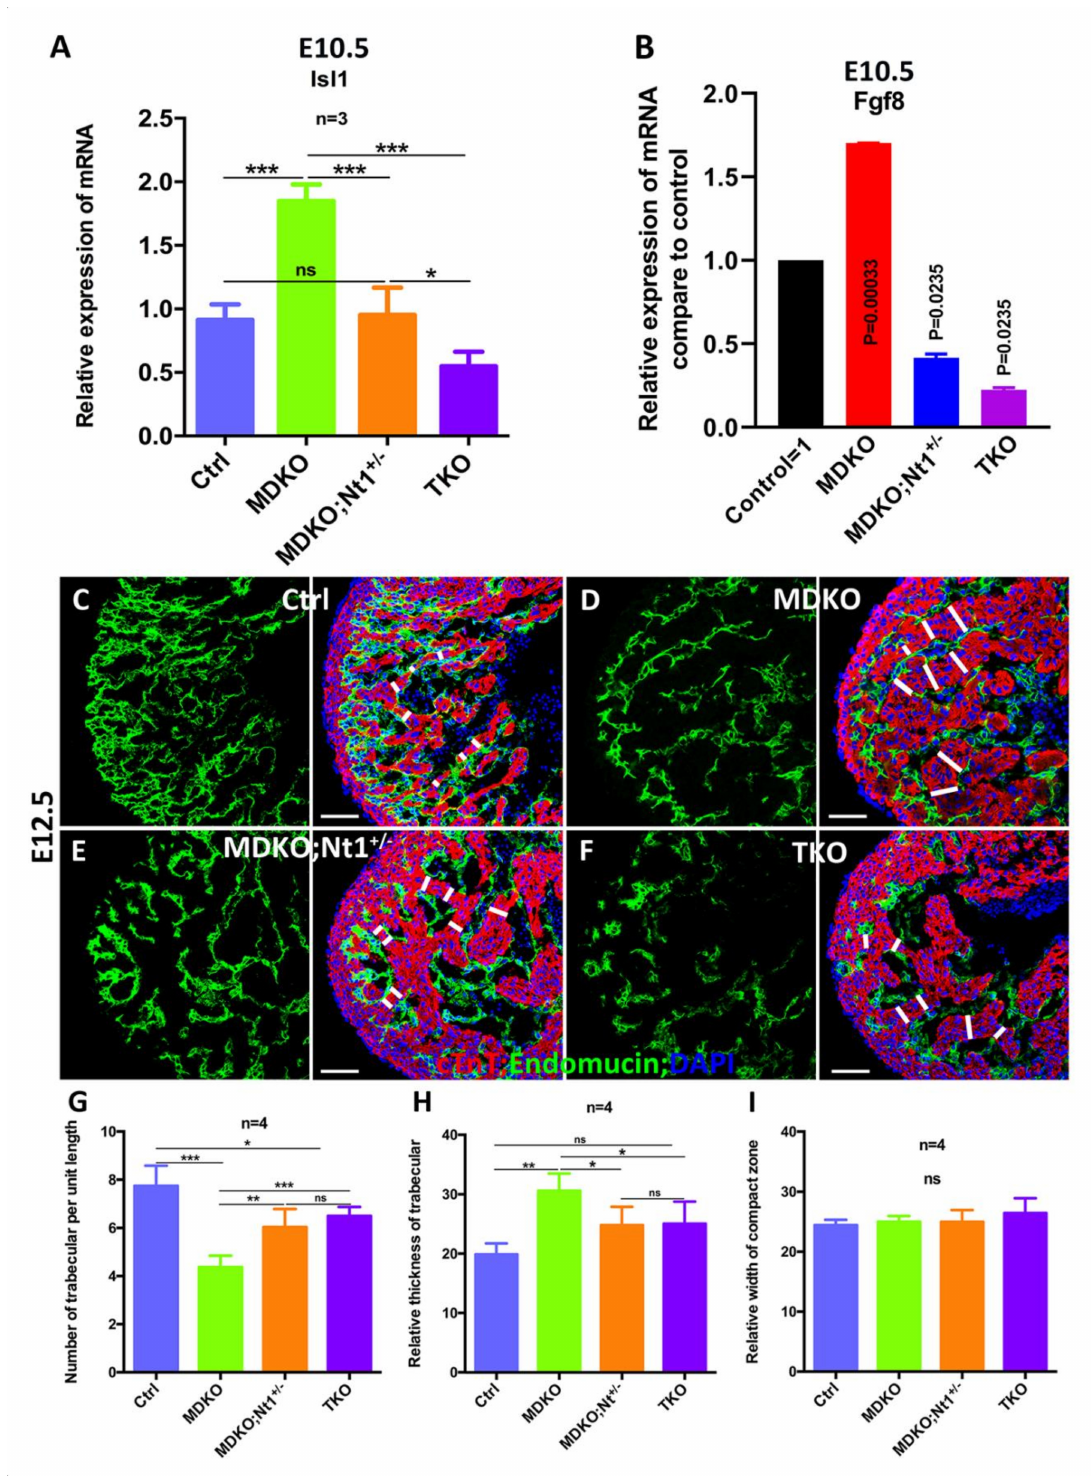
Figure 5. NFPs regulate progenitor cell differentiation and trabecular morphogenesis partially through Notch1. ( A ) Isl1 expression is significantly reduced in TKO compared to MDKO at E10.5 based on Q-PCR. ( B ) Fgf8 expression is